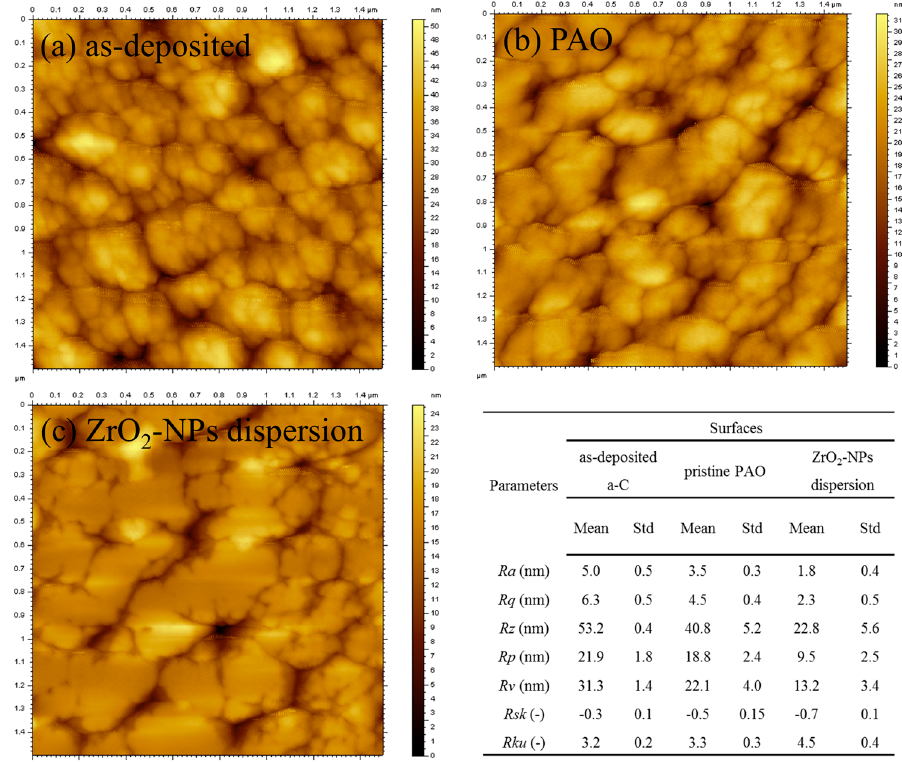
Figure 8. The topography and roughness parameters of: ( a ) as-deposited a-C coating; and the worn a-C surfaces under the lubrication of: ( b ) pure PAO; and ( c ) ZrO 2 -NPs dispersion.